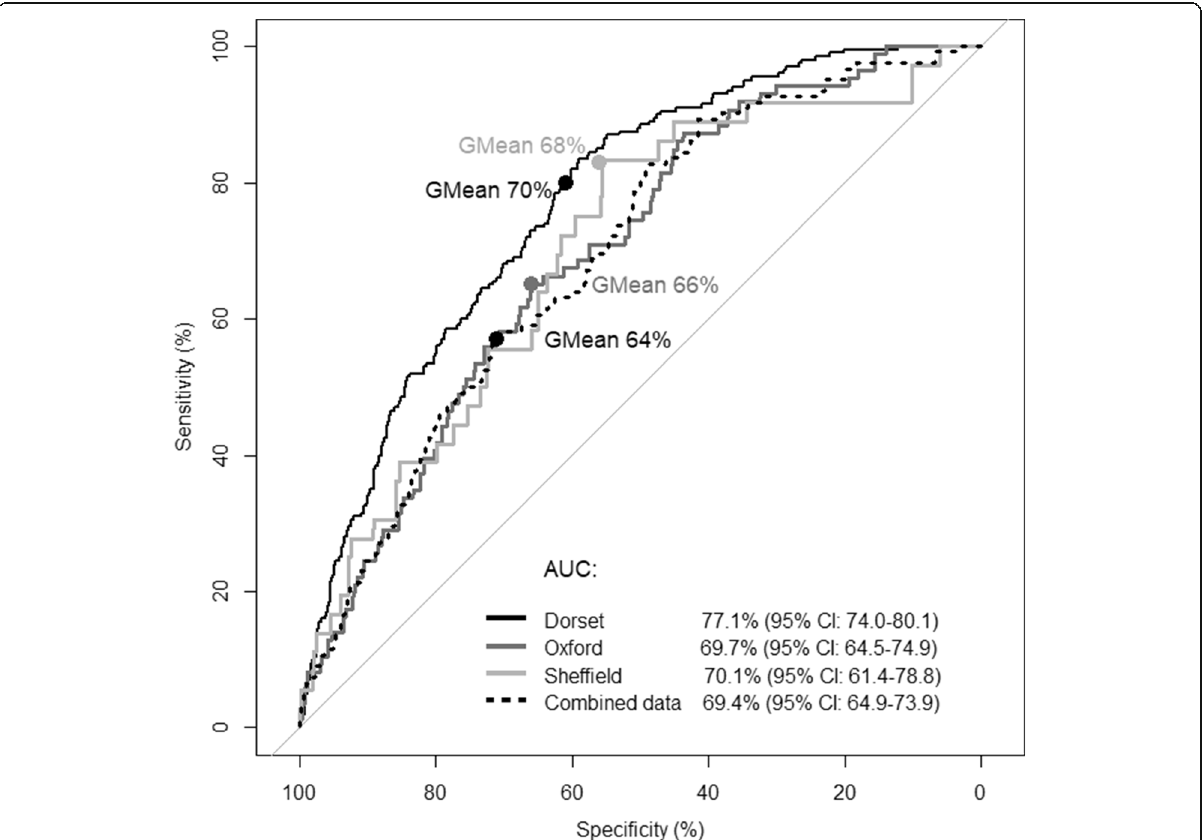
Fig. 1 Receiver operating characteristic curve shows the sensitivity on y -axis, and specificity on x -axis for the Dorset (black), Oxford (dark grey), Sheffield (grey) and combined validation (dotted black) datasets with the highest GMean value in each dataset. AUC, area under curve; GMean, geometric mean of sensitivity and